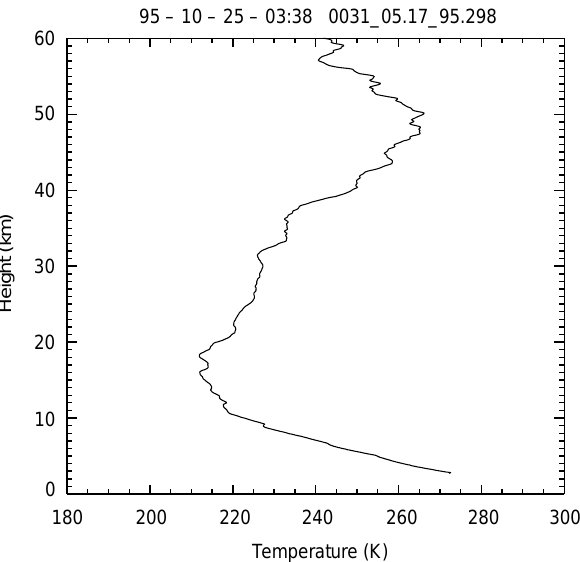
Fig. 9. Wavelike structures in a tropical temperature profile at tropospheric and stratospheric heights (25 Oct. 1995, 2:56 UT, 12 (cid:14) S, 91 (cid:14) W)